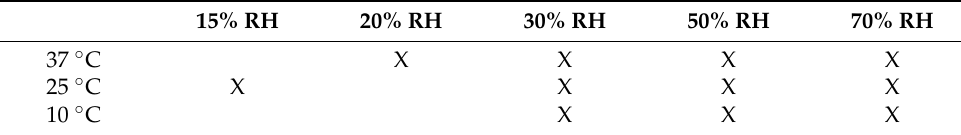
Table 2. Temperature and RH conditions